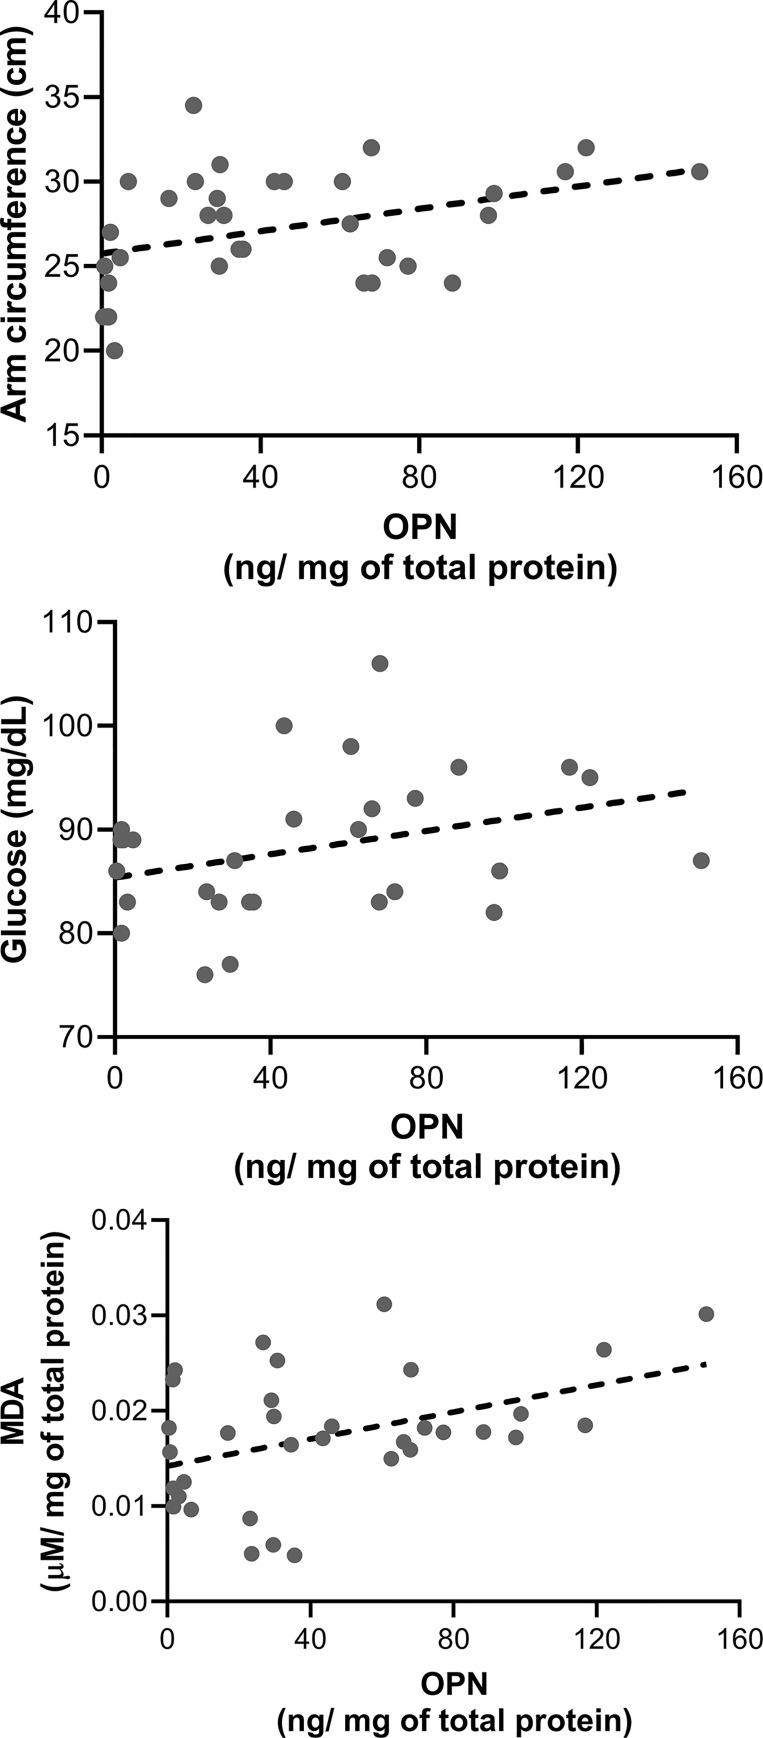
Pearson’s correlation between serum osteopontin and lipid peroxidation marker, glucose, arm circumference, in adolescent’s group.A) Relationship between serum OPN and arm circumference (ρ = 0.3412, p = 0.0449, n = 35); B) OPN and glucose showed a marginal correlation (rho 0.36, p = 0.057), and C); OPN and MDA showed a statistically significant correlation (ρ = 0.3552, p 0.0363, n = 35).